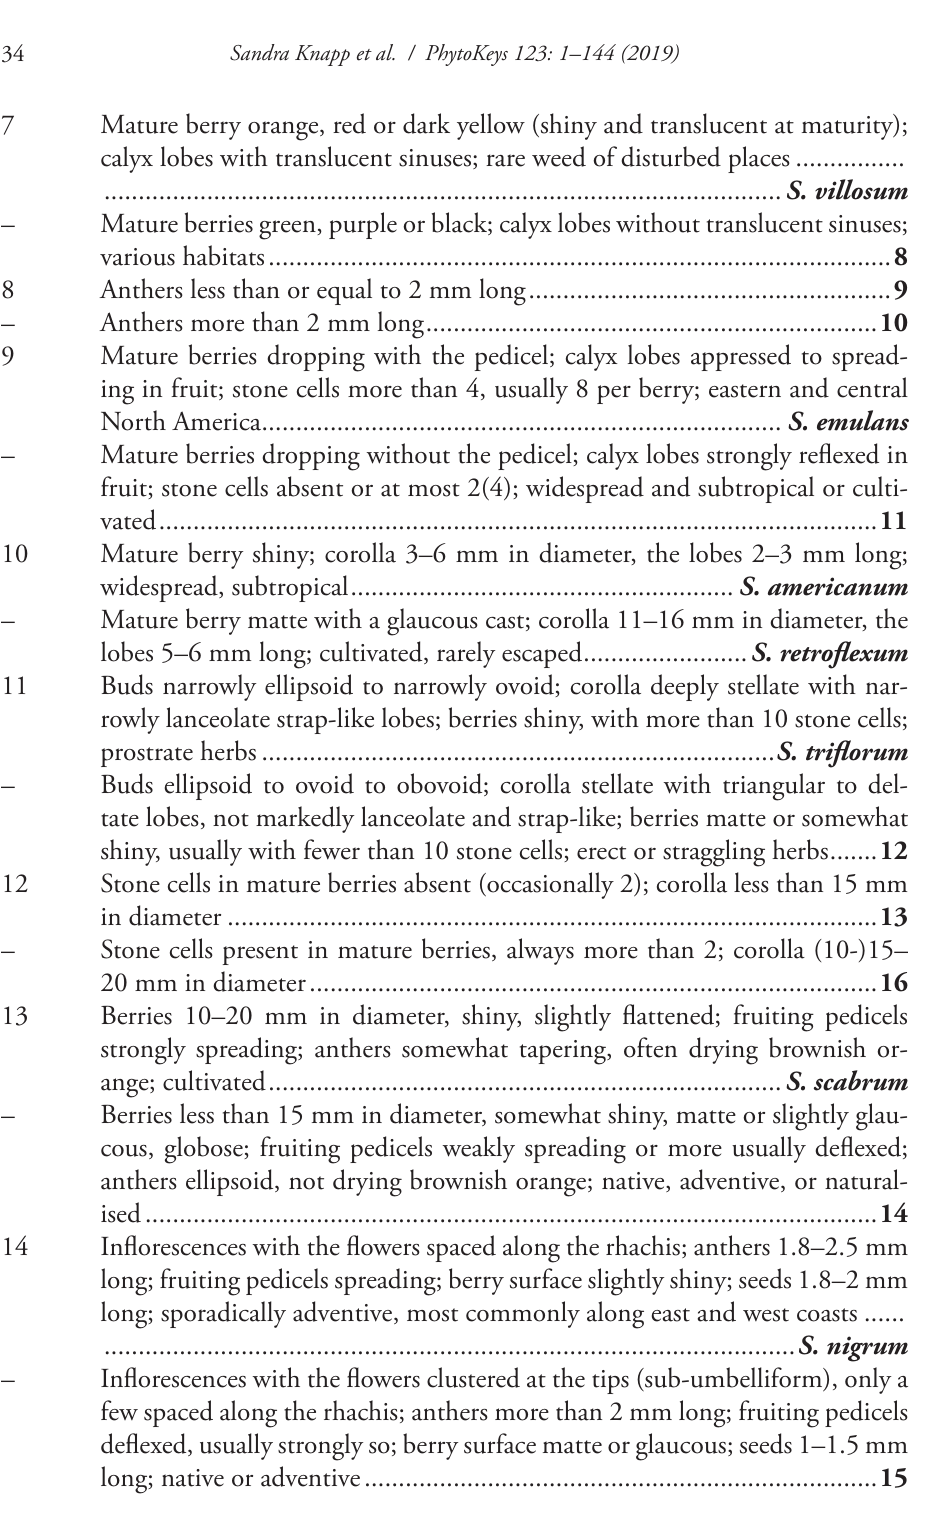
Mature berries green, purple or black; calyx lobes without translucent sinuses;